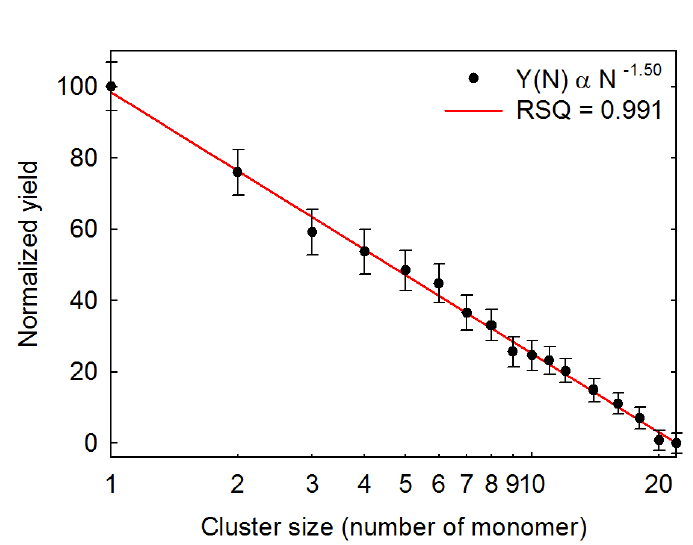
Figure 7. Cluster size distribution of BSA from monomer to 22-mer. The cluster size (x-axis) and the normalized relative intensity (y-axis) are plotted on a base-10 logarithmic scale.